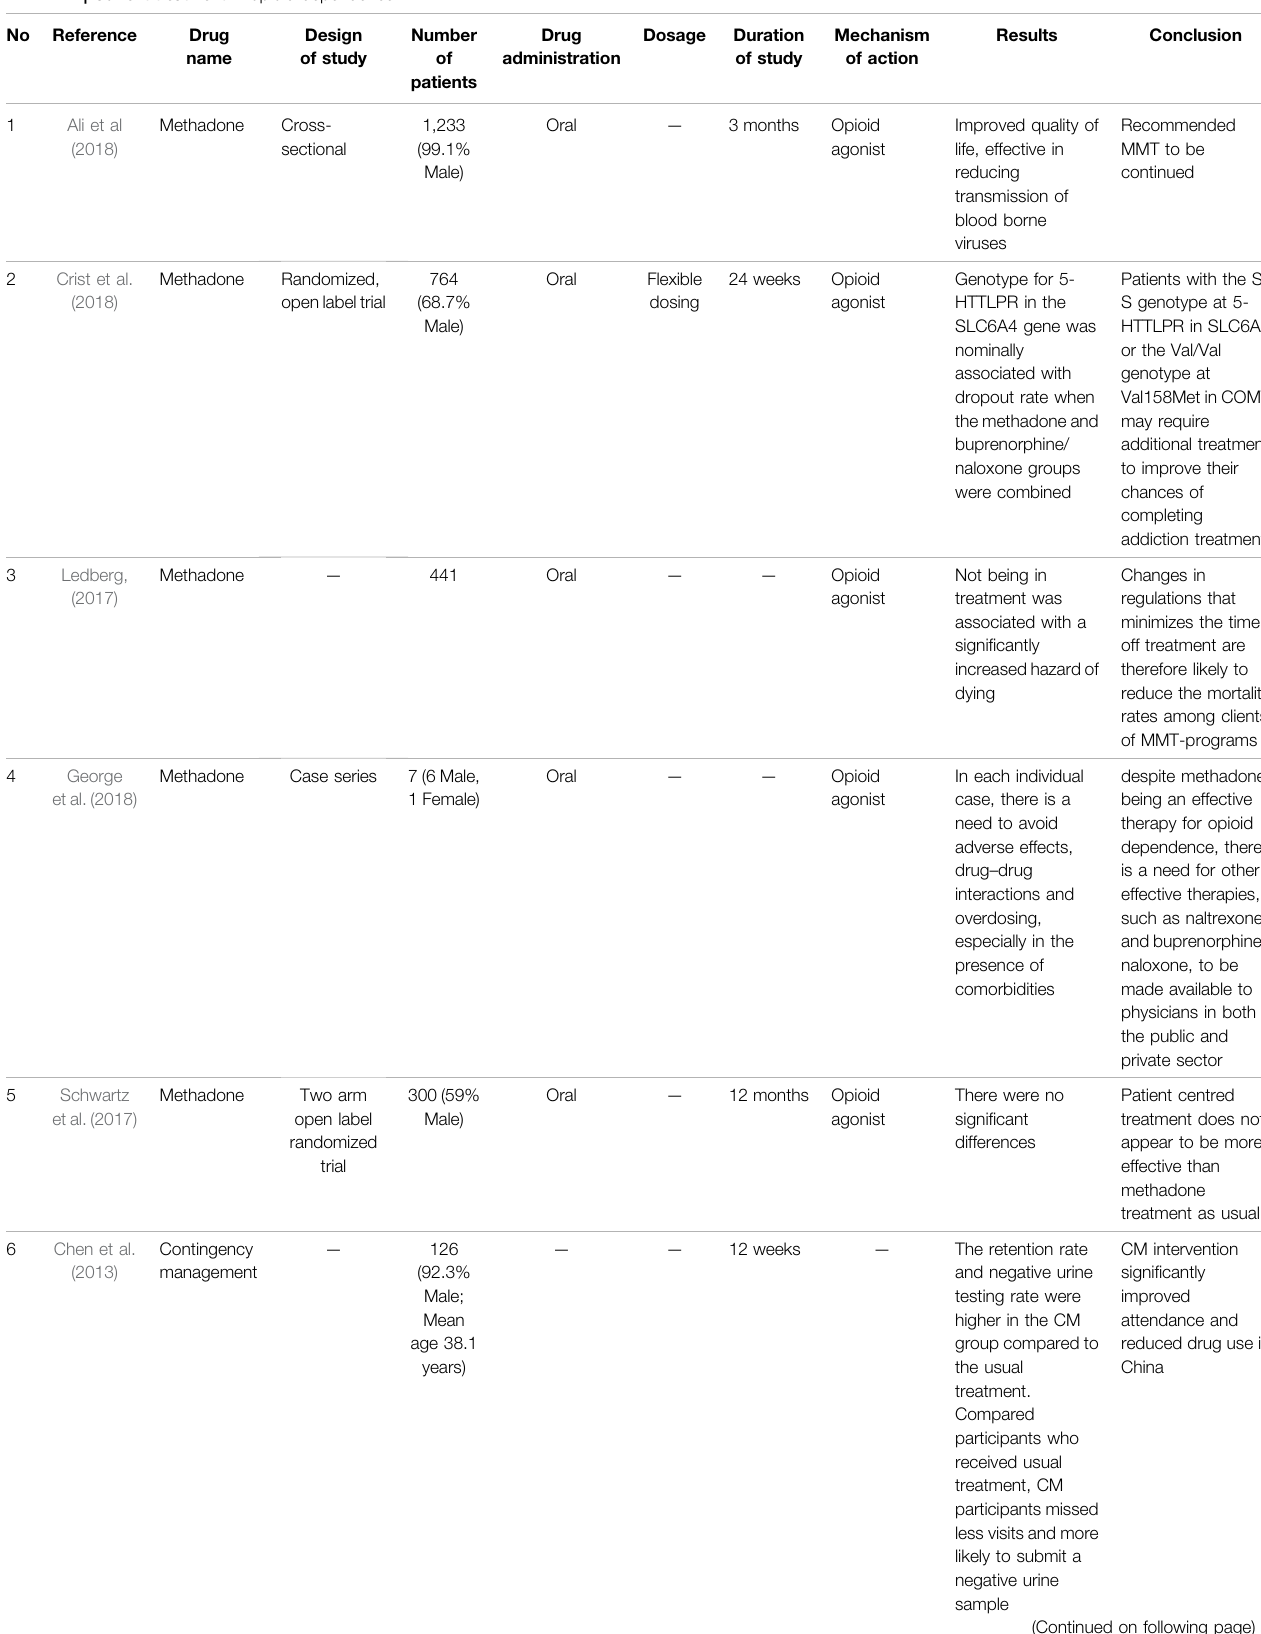
TABLE 1 | Current treatment in opioid